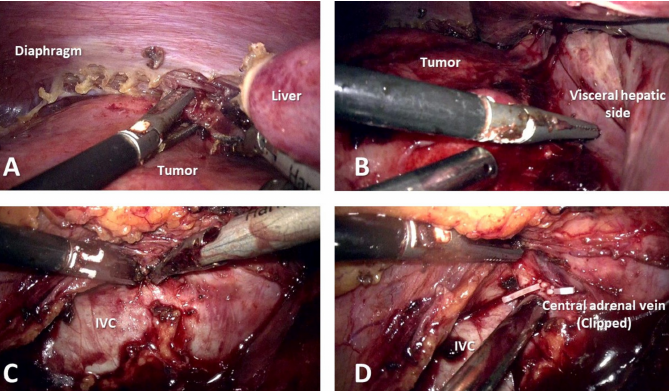
Figure 3. Intraoperative images. ( A ) Tumoral invasion of the diaphragm. ( B ) Infiltration of the visceral side of the liver. ( C ) Difficult isolation of inferior vena cava. ( D ) Central adrenal vein clipped and divided.